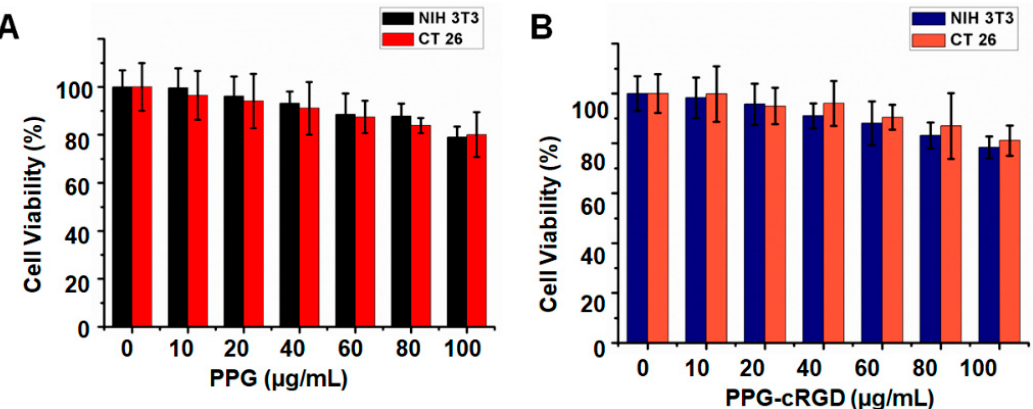
Figure 5. Viability of CT26 cells and NIH 3T3 cells after treatment with PPG NPs ( A ) and PPG-cRGD NPs ( B ) at different concentrations for 24 h. Data are shown as average ± S.D. ( n = 4).